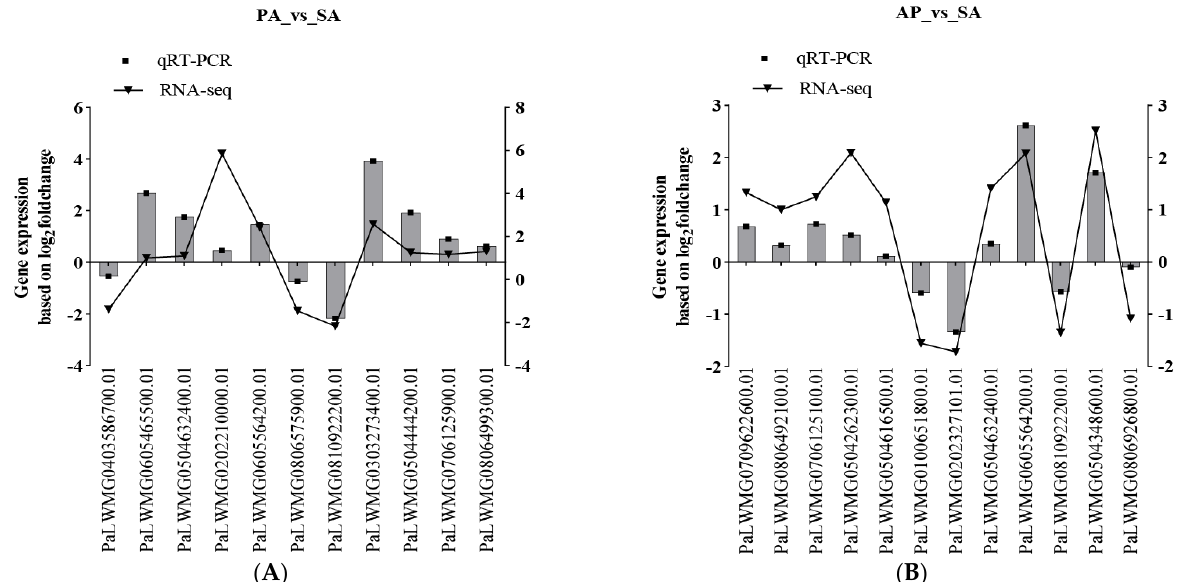
Figure 8. qRT-PCR analysis of peach/apricot (PA) and apricot/peach (AP). ( A ) qRT-PCR analysis of the relative expression levels of 11 DEGs in the PA; ( B ) qRT-PCR analysis of the relative expression levels of 12 DEGs in the AP.